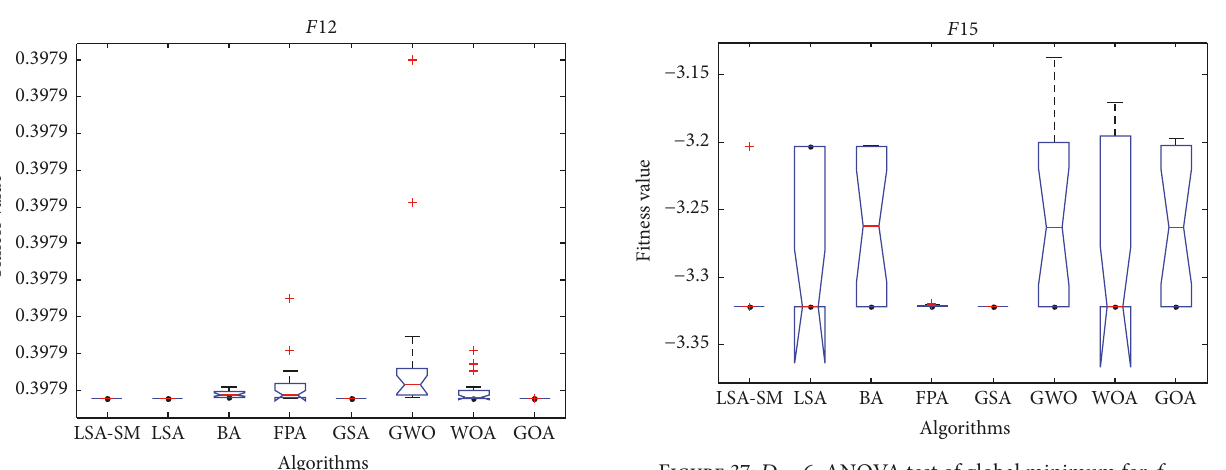
Figure 34: 𝐷 = 2 , ANOVA test of global minimum for 𝑓 12 .